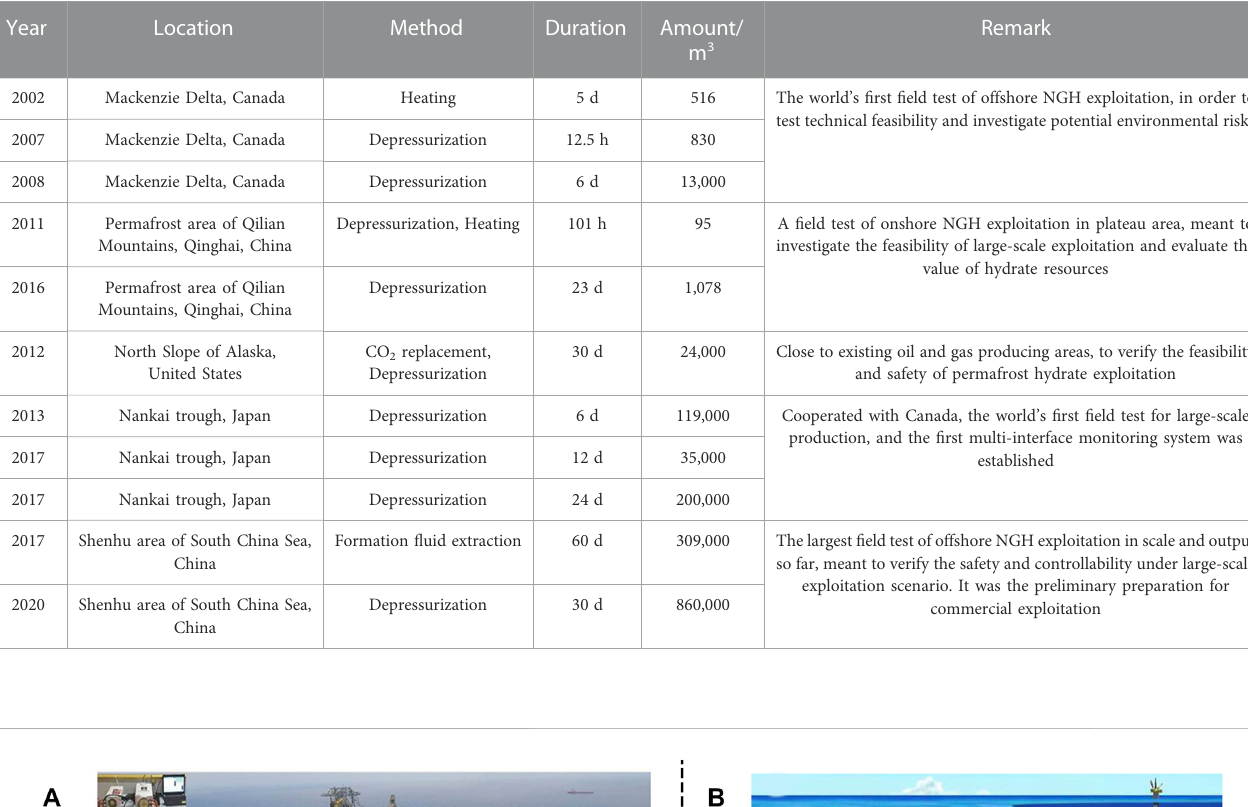
TABLE 1 NGH production fi eld tests.